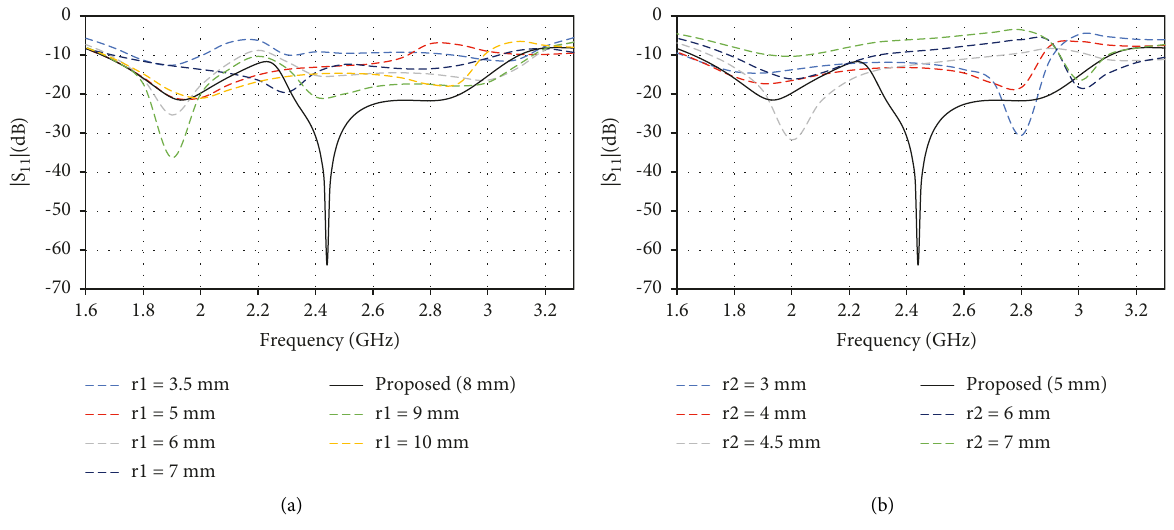
Figure 4: Parametric analysis of the two orbital circular slots. (a) r 1 and (b) r